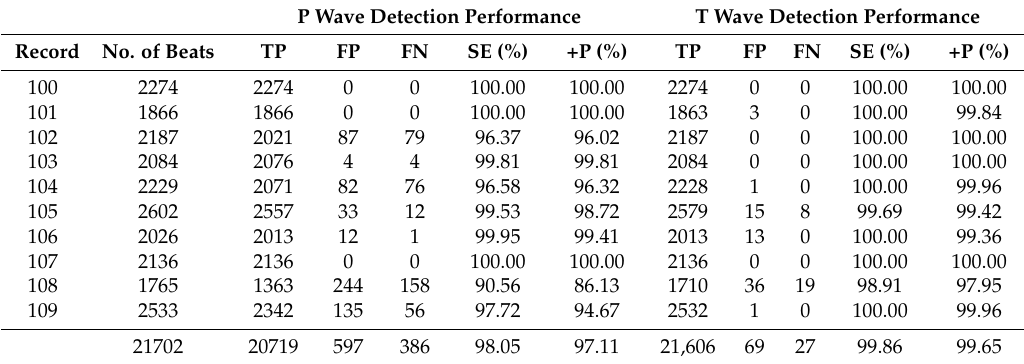
Table 2. P and T waves detection performance over 10 records from the MIT-BIH